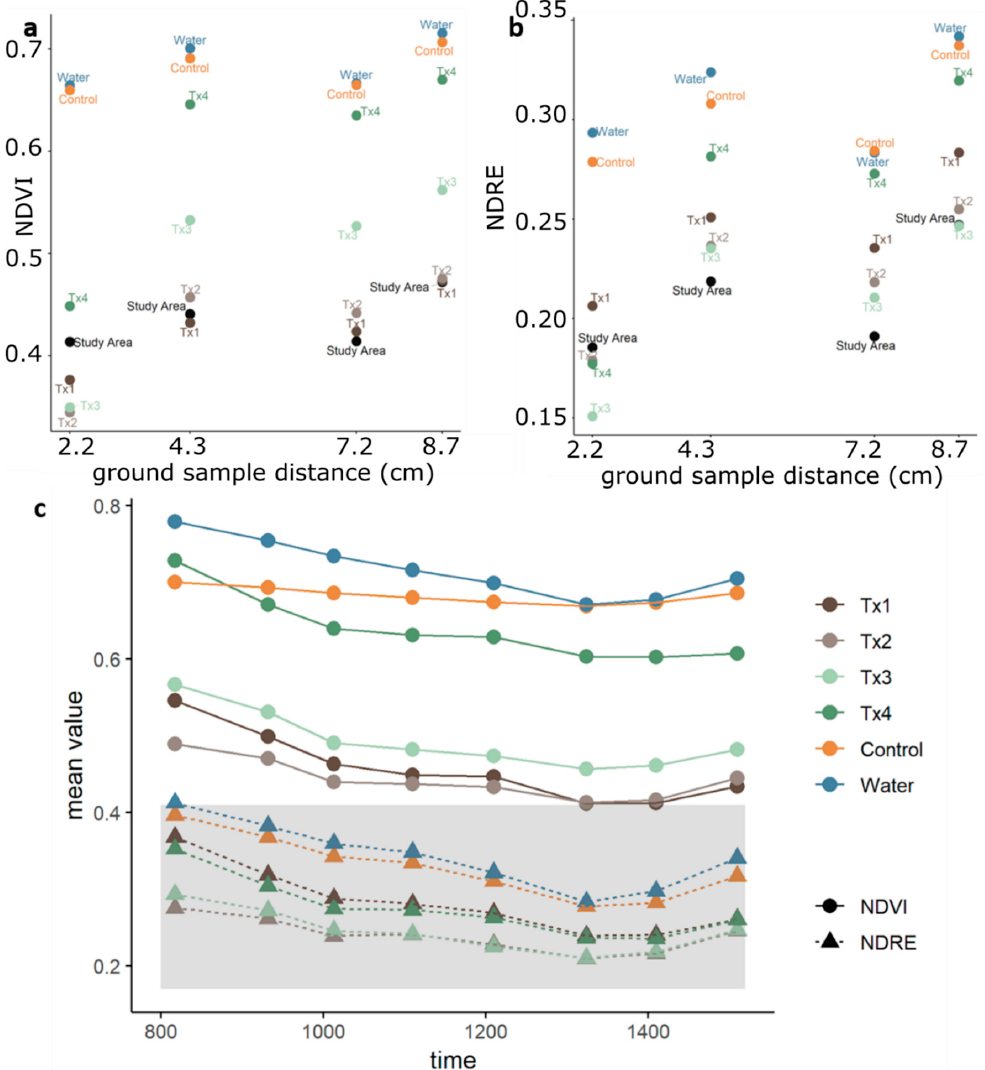
Figure 2. ( a ) NDVI values and (b) NDRE values per treatment for flights with GSD of 2.2 cm, 4.3 cm, 7.2 cm, and 8.7 cm (flying height of 30m, 60m, 100m, and 120m); and (c) spectral index value per treatment over the course of eight flights in one day (resampled to 4.3 cm resolution). NDVI: normalized difference vegetation index. NDRE: normalized difference red edge index.